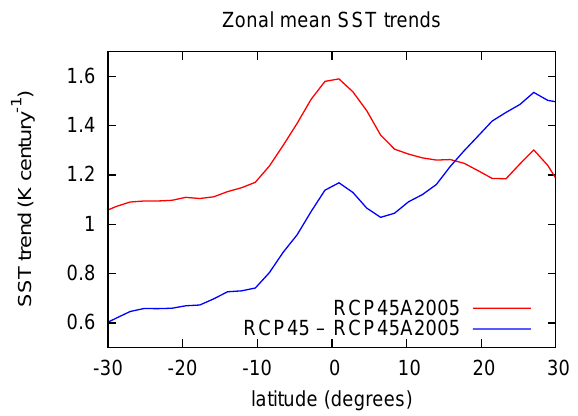
Fig. 9. 2006–2100 zonal-mean SST trends at low latitudes from RCP45A2005 (red curve) and RCP45 minus RCP45A2005 (blue